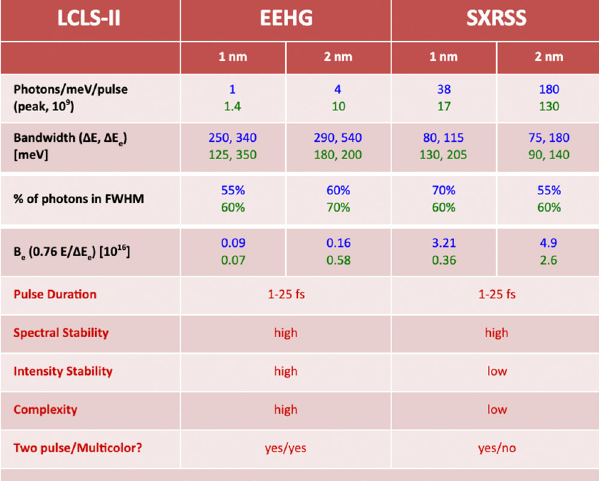
FIG. 3. Seeded LCLS-II performance comparison. Δ E e is the FWHM equivalent of a Gaussian, and is the minimum spectral extent that contains 76% of the total energy, E N ¼ NE ph . This incorporates spectral pedestal contributions that are missed by the conventional FWHM, Δ E . All values calculated near saturation at the undulator position that gives the peak of B e ¼ 0 . 76 E N = Δ E e , which is the number of photons contained within the relative FWHM equivalent bandwidth. For comparison, unmo- nochromatized SASE averages 10 9 photons = meV at 1.2 keVand 4 × 10 9 photons = meV at 620 eV. For comparison with other general features of monochromatized SASE see